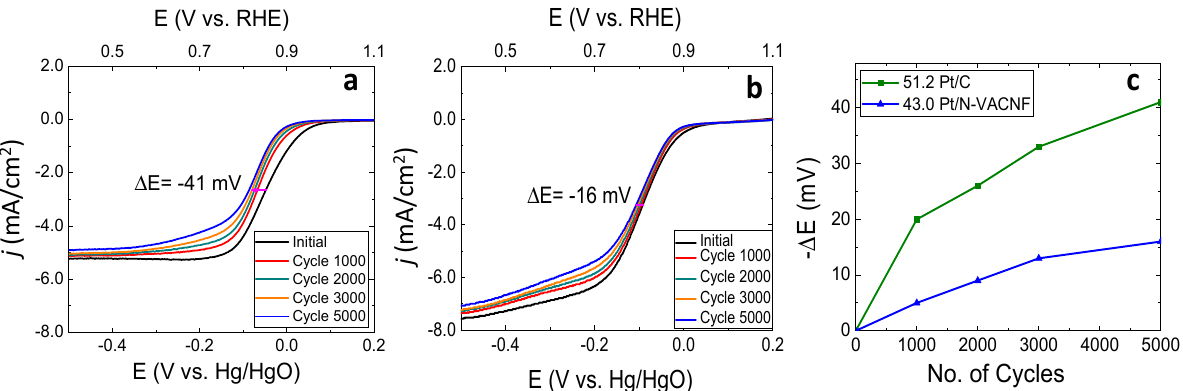
Figure 6. LSV curves of ( a ) Pt/C (51.2 µ g/cm 2 ) and ( b ) Pt/N-VACNF (43.0 µ g/cm 2 ) after every 1000 AST cycles in O 2 -saturated 0.10 M KOH solution at a scan rate of 10 mV/s and a rotation speed of 1600 rpm; ( c ) Change in the half-wave potential of the LSV curves vs. the number of AST cycles for all the catalysts.